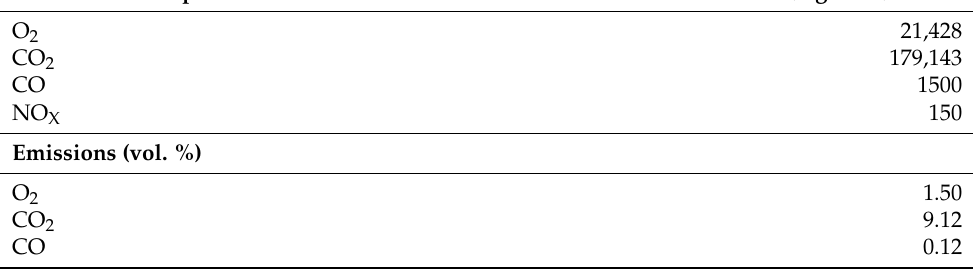
Table 8. Exhaust gas composition from the spark–ignition engine running on the producer gas from gasification of exhausted olive pomace